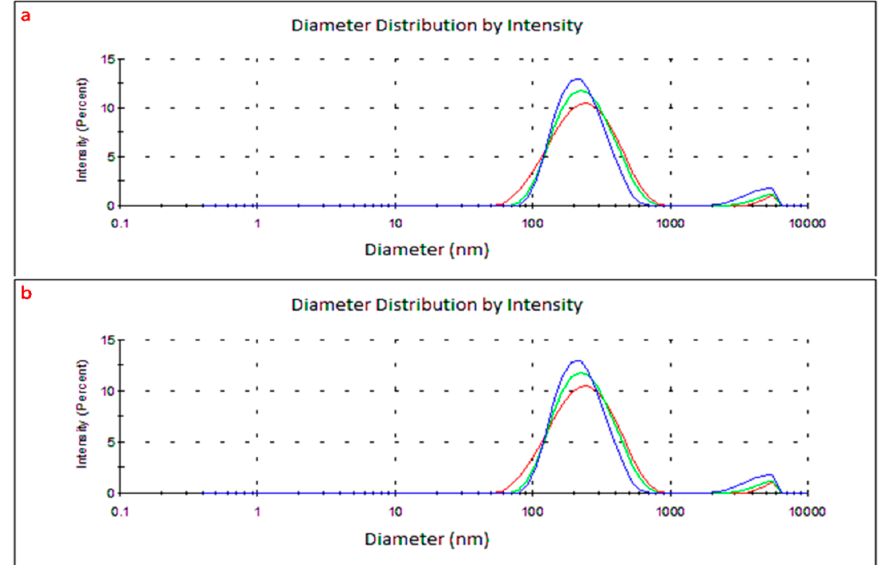
Figure 6. Graphical representation of PS liposomes diameter without encapsulated extract of Stellaria media (L.) Vill. ( a ) and PSE liposomes with encapsulated extract of Stellaria media (L.) Vill. ( b ) . The size of PS-type liposomes was between 58 nm and 2500 nm, with 93% of them being in the range of 58–1000 nm (Figure 7a).